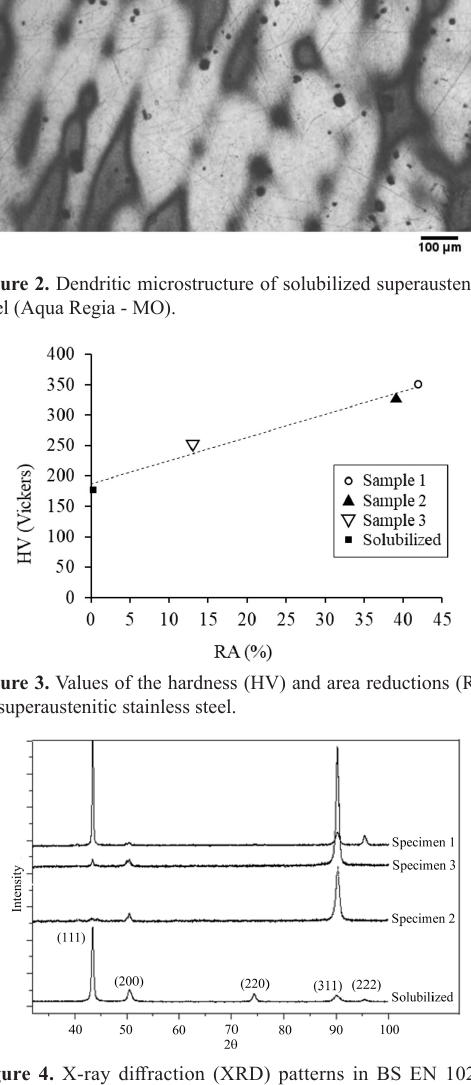
Figure 4. X-ray diffraction (XRD) patterns in BS EN 10283 Nº 14587 steel: austenite peaks intensities of the solubilized and deformed regions.